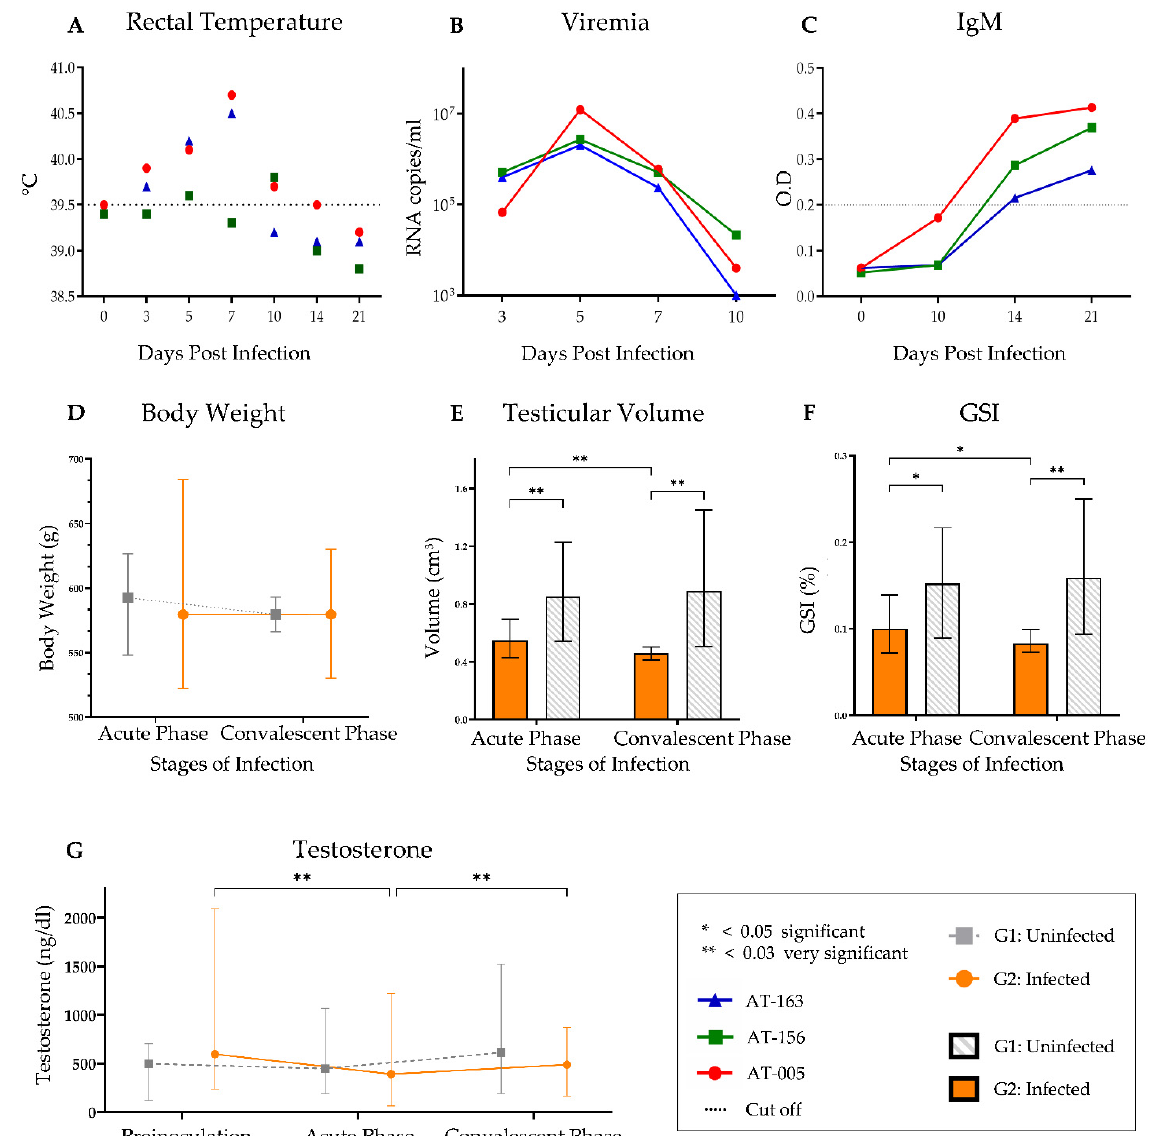
Figure 2. Noninvasive evaluation of experimental ZIKA infection in male S. collinsi . ( A ) Measurement of rectal temperature, showing feverish period of infected group between 3 to 10 dpi. The dashed line represents the temperature cut-off based in control group data. The ( B ) RNA viral load in blood by RT-qPCR and ( C ) IgM antibody profile of the infected group detected from 14 dpi. The dashed line represents the cut-off of ELISA assay. Group evaluation, mean and min-max values: ( D ) body weight, ( E ) testicular volume, ( F ) gonadosomatic index, and ( G ) testosterone by stages of infection, highlighting the decrease of testicular volume, GSI and testosterone values during acute phase of infection in G1.